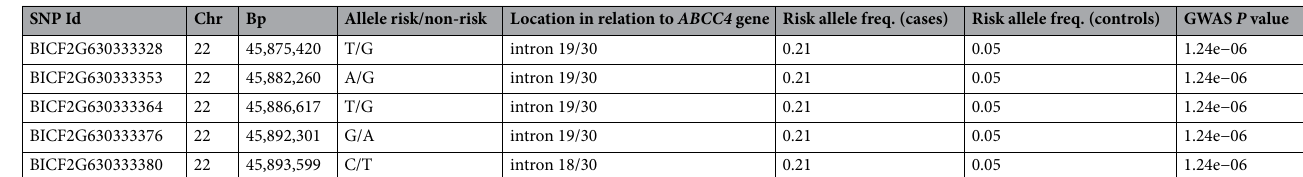
Table 1. Significantly associated GWAS SNPs. The CanFam3.1 genomic coordinates are shown for the five associated GWAS SNPs reaching Bonferroni corrected significance. Allele frequency in cases and controls for the 98 cases and 96 controls is